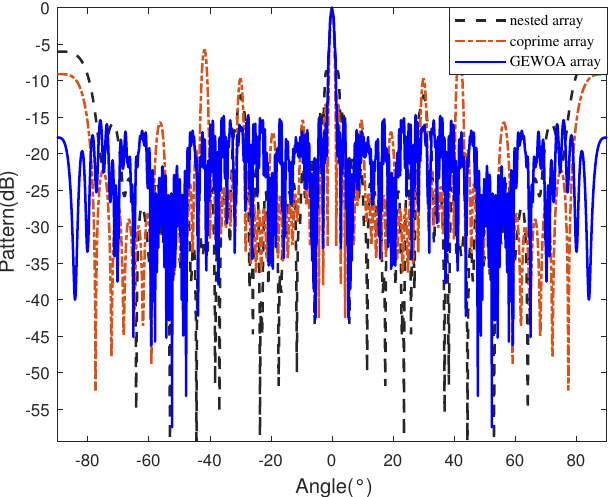
Figure 17. Beampatterns of the coprime array, nested array, and GEWOA